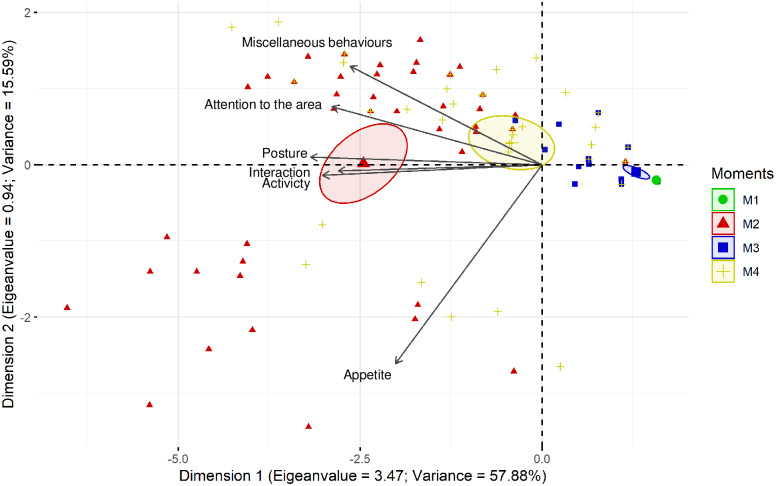
Principal component analysis of the items of the UPAPS.UPAPS—UNESP-Botucatu pig composite acute pain scale. Data were obtained from the gold standard observer analysis at four evaluation moments. Each number corresponds to one pig and each colour corresponds to one moment (M1—green, pigs 1 to 45; M2—red, pigs 46 to 90, correspond to pigs from 1 to 45 of M1; M3—blue, pigs 91 to 135, correspond to pigs from 1 to 45 of M1 and M4—yellow, pigs 136 to 180, correspond to pigs from 1 to 45 of M1). The ellipses were constructed according to the pain assessment moments (M2—red, M3—blue, and M4—yellow). The ellipse corresponding to the moments pigs were suffering intense (M2) and moderate pain (M4) are positioned at the left side of the figure. On the opposite side are the ellipses corresponding to the moments pigs were probably not suffering pain (M1 and M3). All items on the scale were influenced by pain (M2 and M4) since their vectors are positioned in the direction of these ellipses.